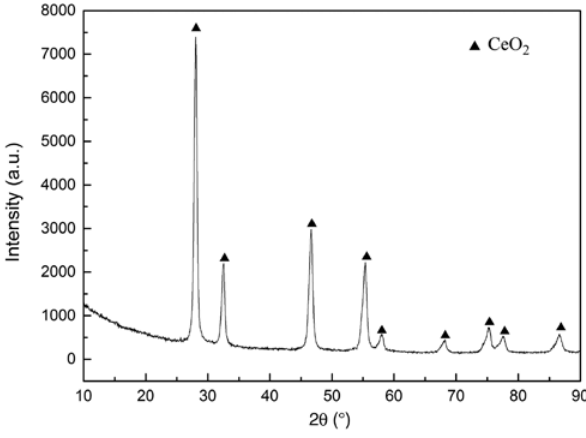
Figure 7: XRD pattern of samples after microwave